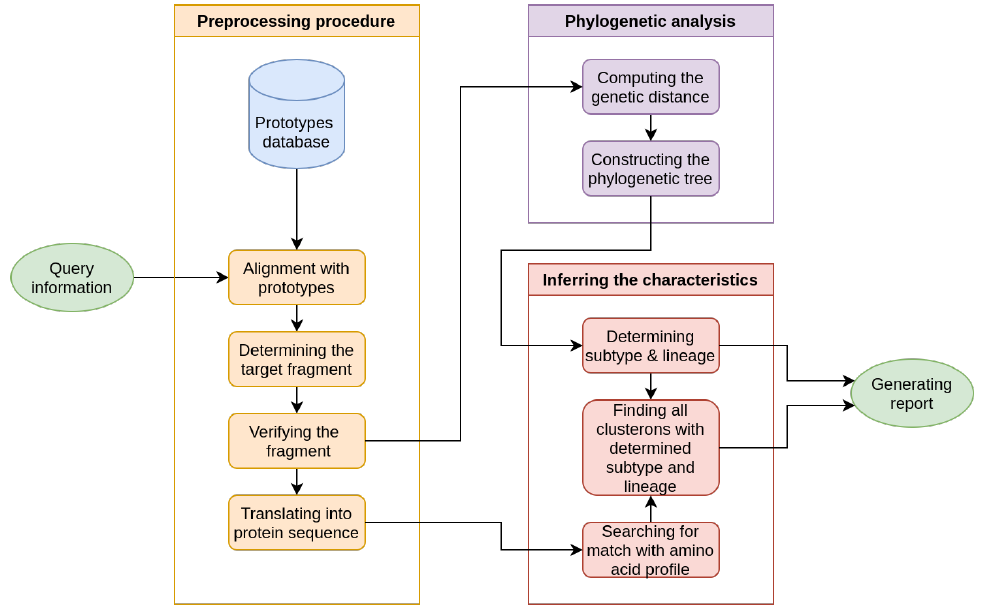
Figure 1. The overall schema of the computational pipeline for clusteron structure application. The pipeline generally includes alignment, identifying a target coding sequence of an E protein fragment, constructing the phylogenetic tree, and inferring/verifying the assigned clusteron to the query. Note that assigning a clusteron to a query requires verification at both the nucleotide and amino acid